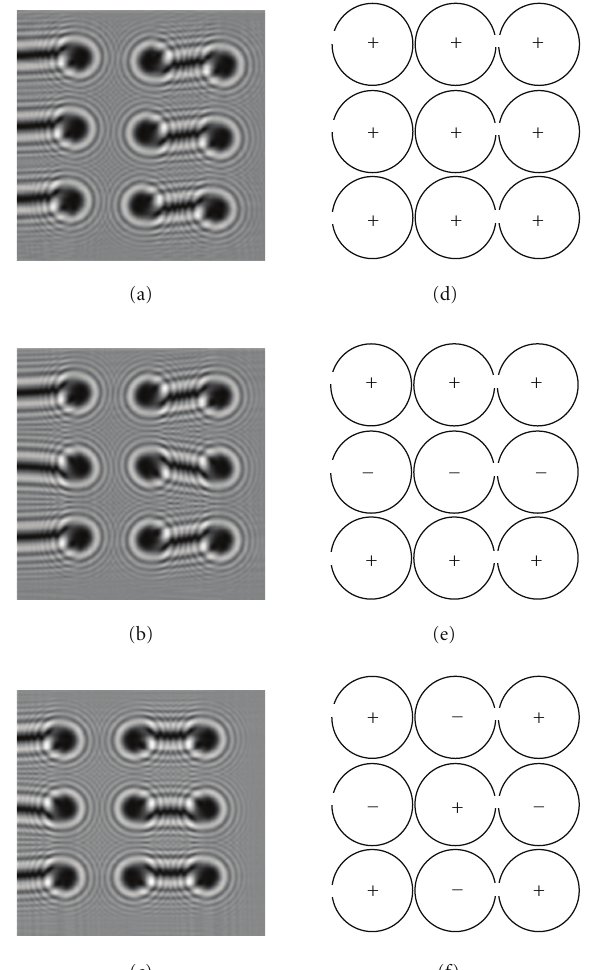
Figure 9: 3 × 3 lattices of fractional vortices each of charge ± 3 . 5 embedded in a Fresnel lens. Simulated intensity distributions (a–c) and the corresponding charge distributions (d–f) are